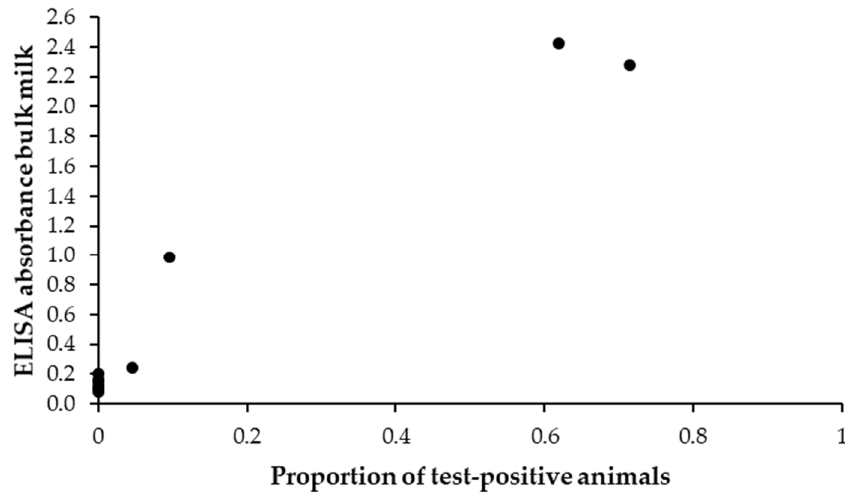
Figure 3. Absorbance value of bulk milk analysed in CAE ELISA compared to proportion of test- positive goats (serum) in the herd in 10 herds and 213 lactating goats included in the study to estimate the occurrence of CAE and CLA (Sweden, 2018).